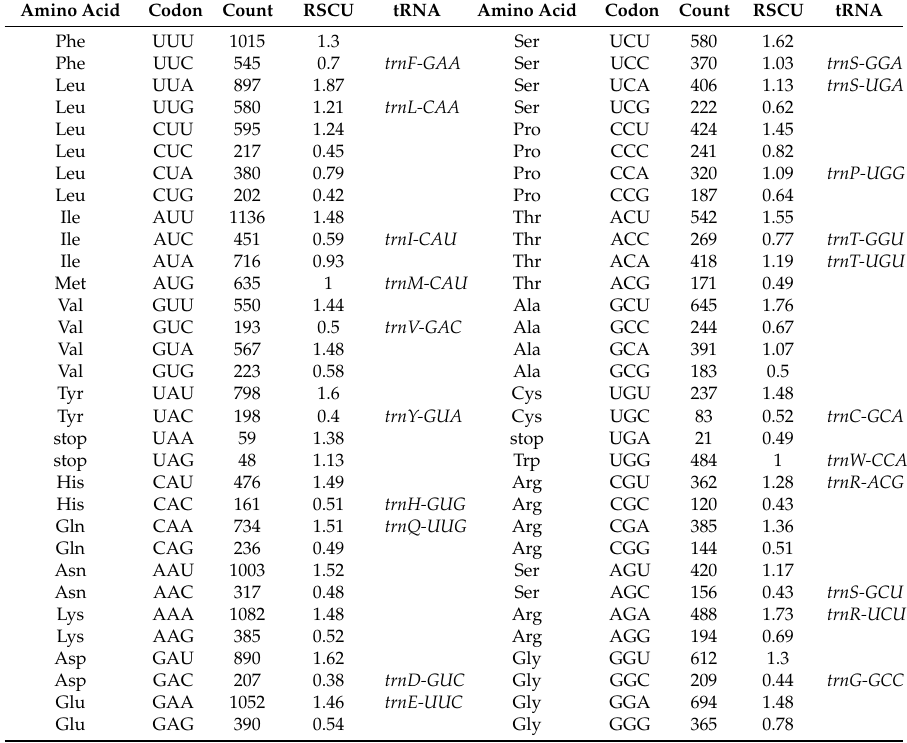
Table 2. Condon-anticodon recognition patterns and codon usage of the Rosa chinensis var. spontanea chloroplast